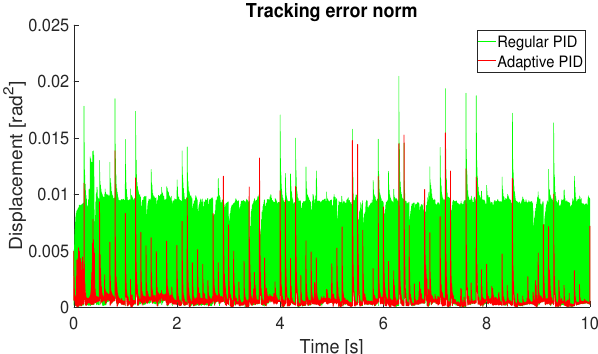
Figure 4. Tracking error signals